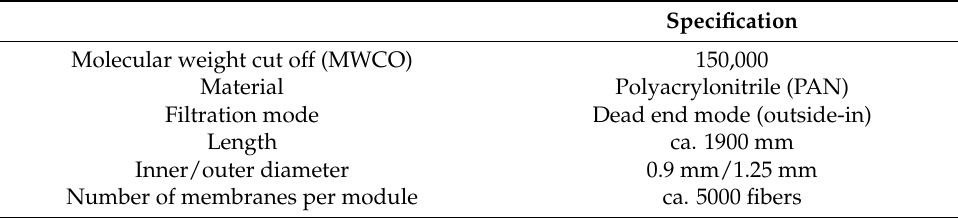
Table 2. Specifications of the hollow fiber